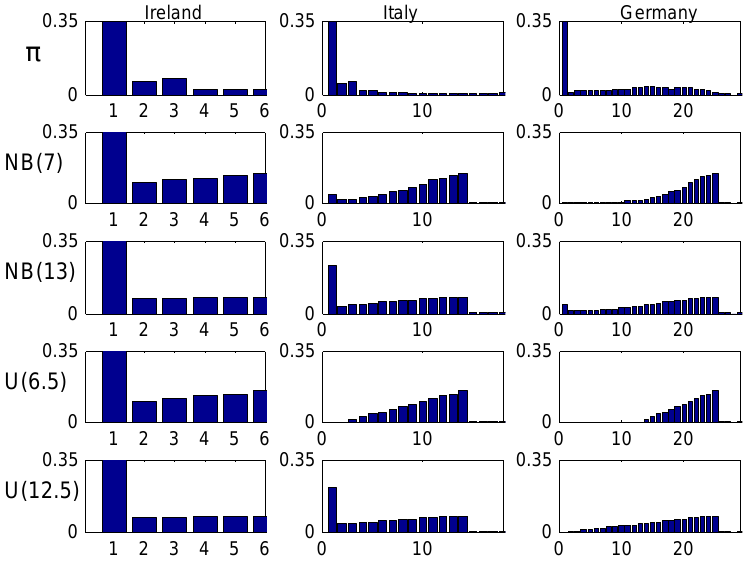
Figure 13. Population averaged age-corrected distributions: population mean